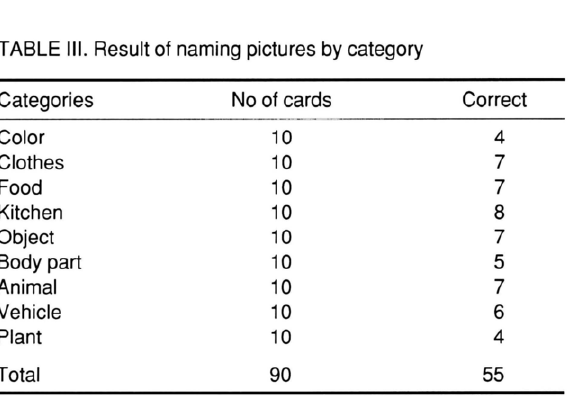
in identifying familiar manipulable objects. The